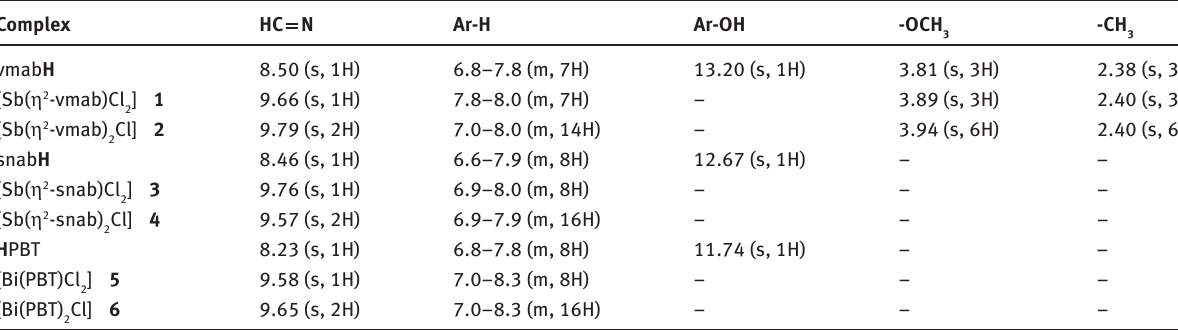
Table 3: 1 H NMR data (ppm) for new complexes 1–6 .